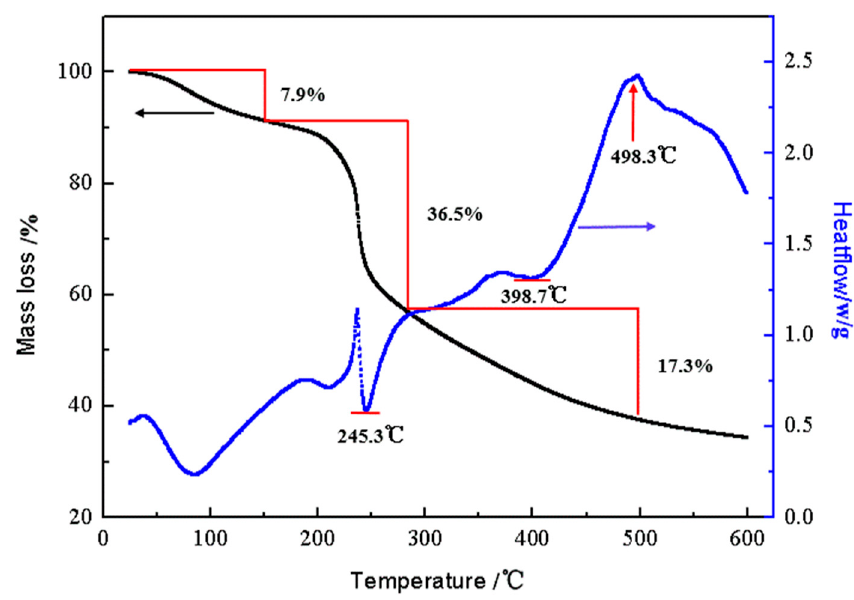
Figure 5. DTA-TGA images of CTS-GSH.